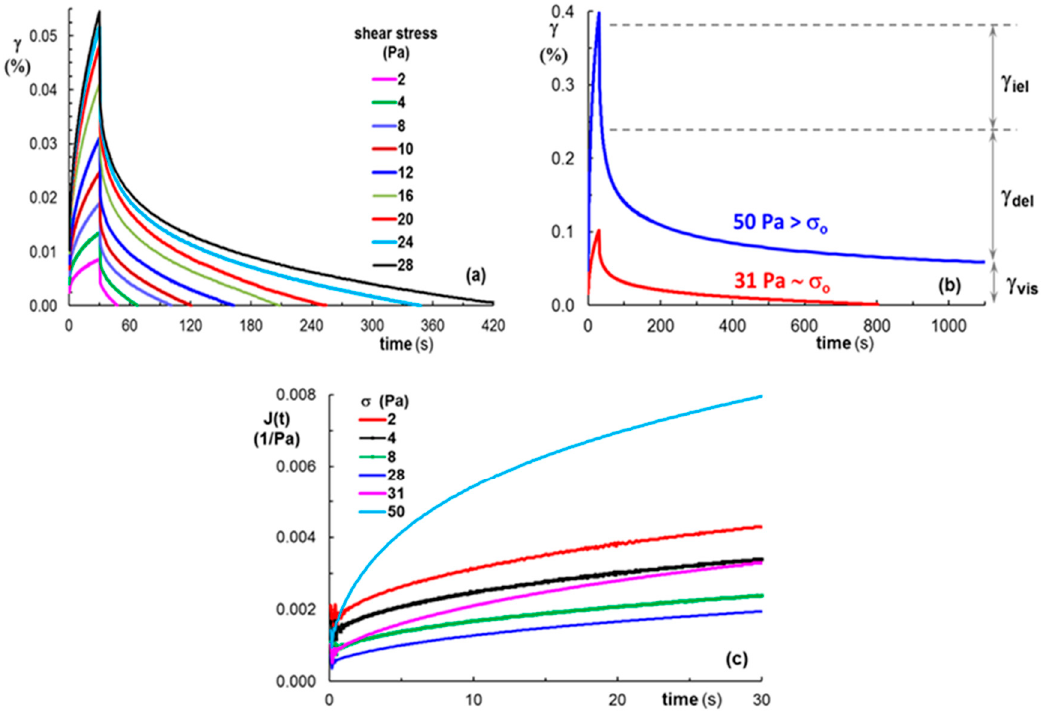
Figure 11. ( a , b ) Strain and ( c ) creep compliance during creep and recovery tests for P3 gel sample submitted successively to increasing shear stress